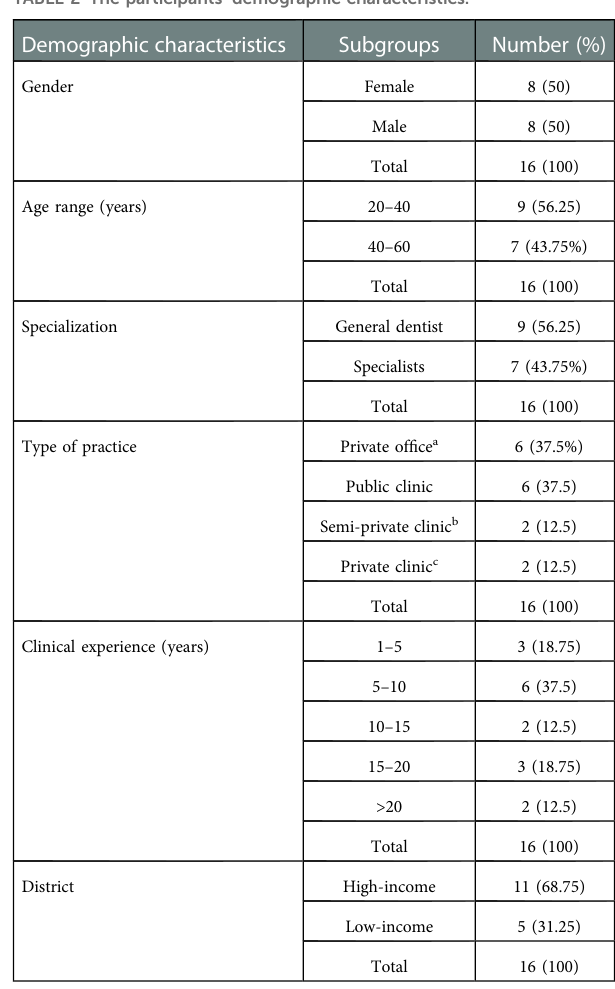
TABLE 2 The participants ’ demographic